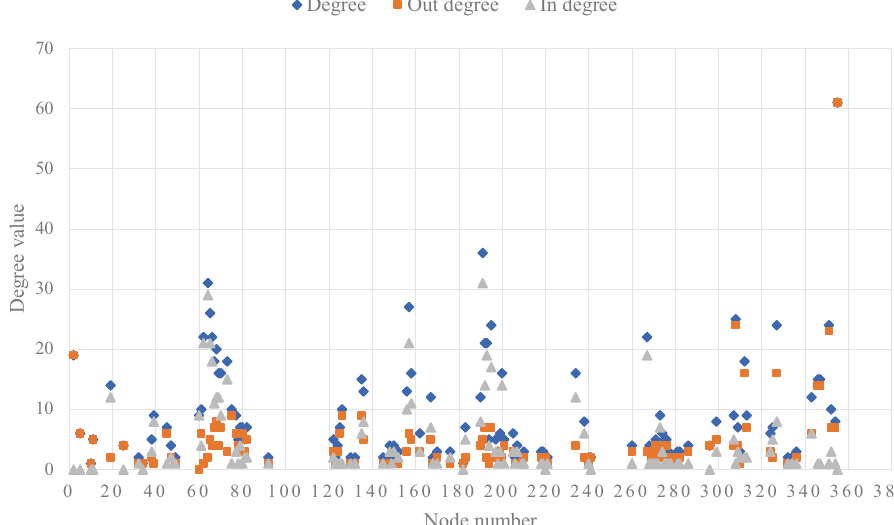
Figure 2. Node degree in the I-FRPN.